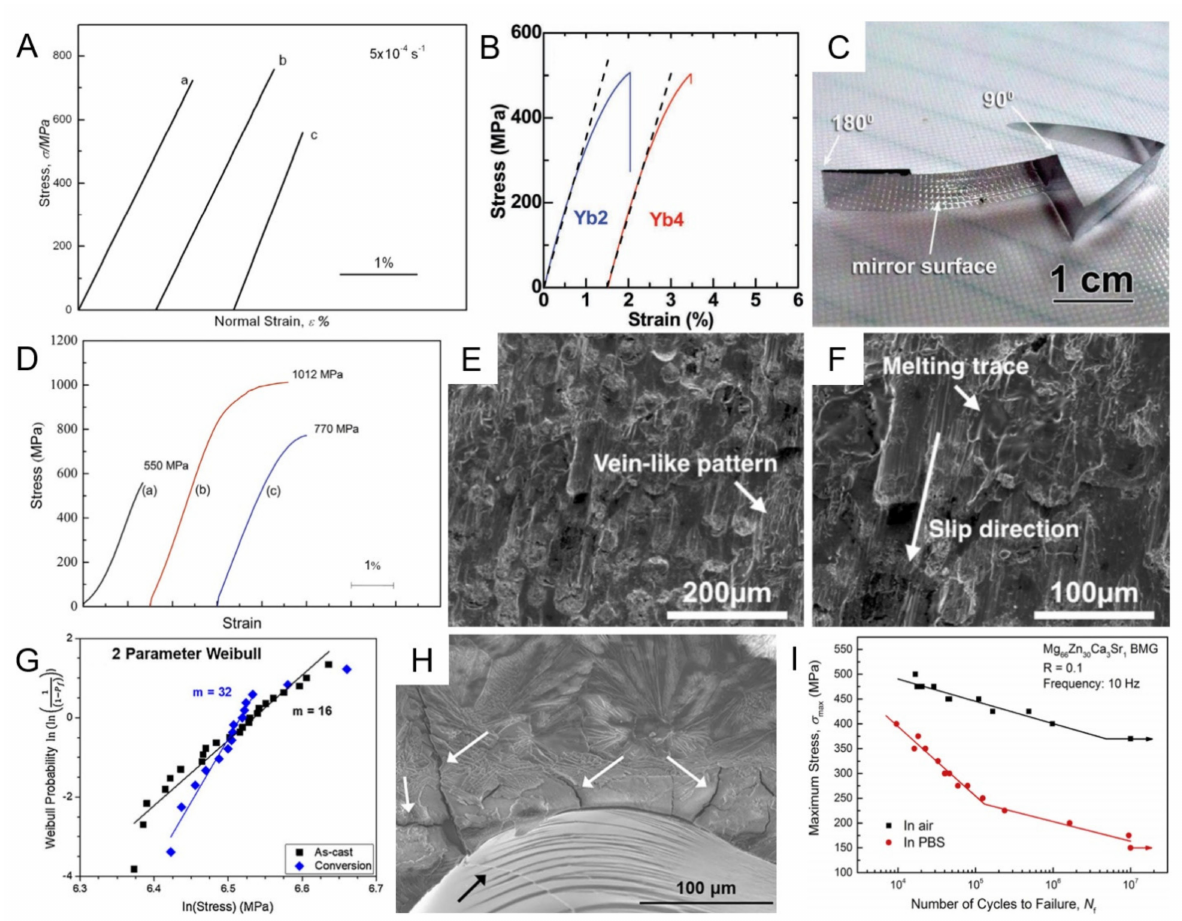
Figure 2. Mechanical properties of Mg–Zn–Ca-based MGs. ( A ) Compressive curves of as-cast Mg 65 Zn 30 Ca 5 , Mg 65 Zn 30 Ca 4 Ag 1 , and Mg 63 Zn 30 Ca 4 Ag 3 alloy rods (2 mm in diameter) under a strain rate of 5 × 10 − 4 s − 1 , reproduced with permission from [83]. ( B ) The plots of tensile stress versus strain curve at strain rate of 10 − 4 s − 1 for the Yb2 and Yb4 MG ribbons, reproduced with permission from [84]. ( C ) The optical image of bent Yb2 MG ribbon, reproduced with permission from [84]. ( D ) Engineering strain–stress curves of the Mg 69 − x Zn 27 Ca 4 Y x alloys: (a) x = 0, (b) x = 1, and (c) x = 2 at.%, reproduced with permission from [59]. ( E ) The vein-like pattern and ( F ) the melting trace and the slip direction of the fracture surface of Mg 66 Zn 29 Ca 5 MGMC with 10 vol% of porous Mo particles, reproduced with permission from [74]. ( G ) Fitted 2 parameter Weibull statistics for the fracture strength of as-cast and PCC compression rods and their corresponding fitted shape parameters (m), reproduced with permission from [89]. ( H ) A micrograph of a conversion-coated sample, following failure under compression (white arrows indicated the coating spalling, cracking, and delamination along the fracture, and black arrow indicated further shear band and crack formation), reproduced with permission from [89]. ( I ) Stress-life curves for the compression–compression fatigue tests in air and in PBS of Mg 66 Zn 30 Ca 3 Sr 1 MG, reproduced with permission from